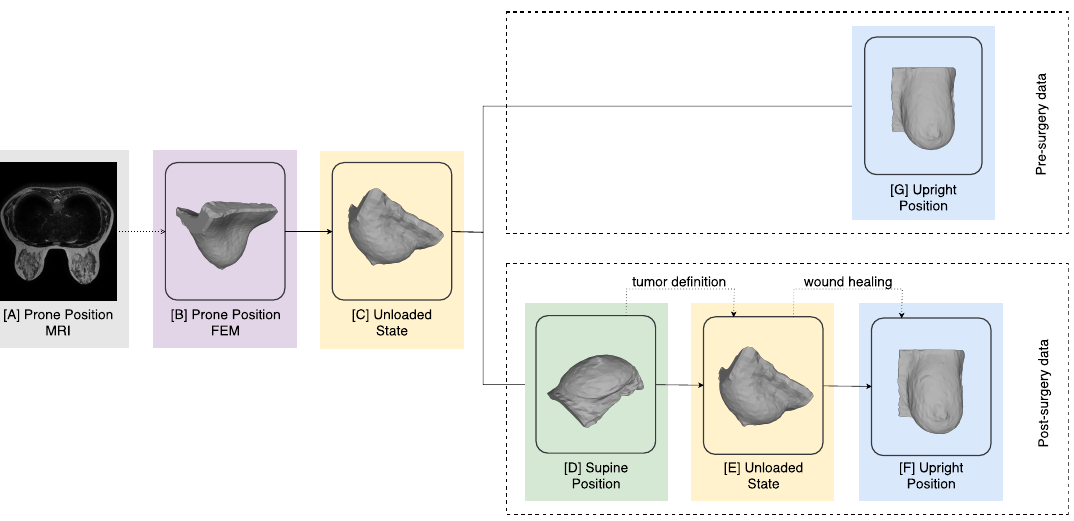
Figure 3. Pose transformation followed pipeline, as proposed by Vavourakis et al.